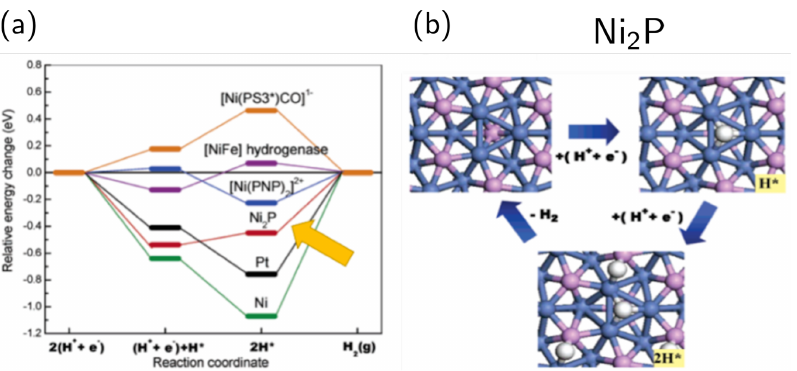
Figure 11. ( a ) Relative energy changes for HER. ( b ) HER mechanism in Ni 2 P surface. Modified from